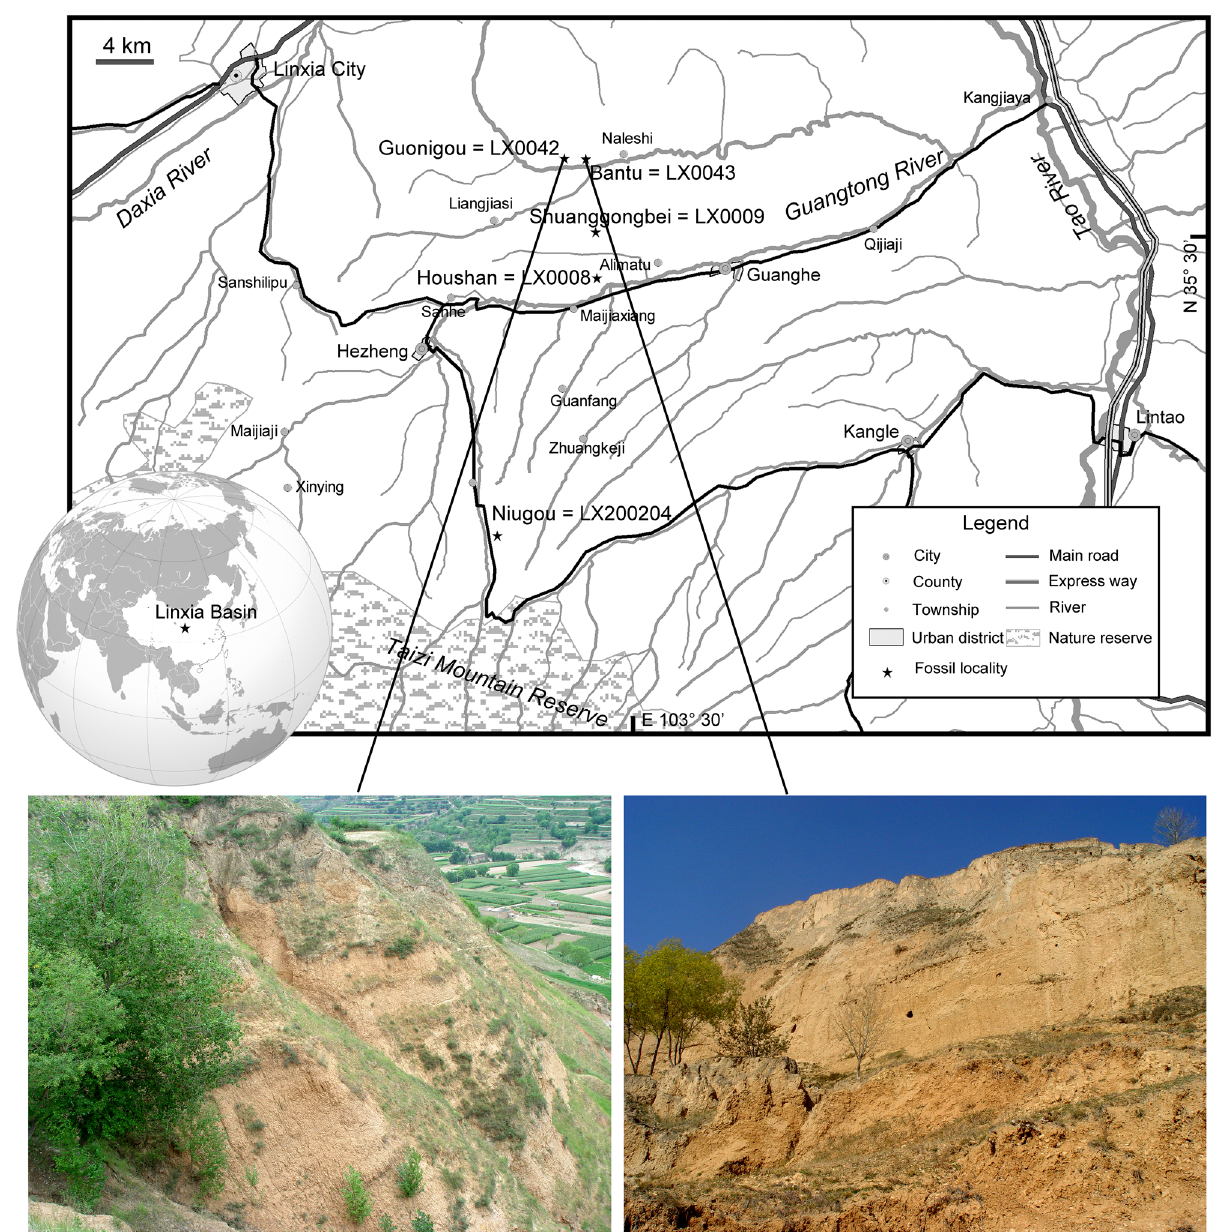
Figure 1. Map and geology of the occurrence area of H . weihoense in the Linxia Basin, with photos of the most significant localities of Eurasian hipparion (generated with Adobe Photoshop version CS 6, based on the locator map provided by S. Wang, and photographs provided by T.